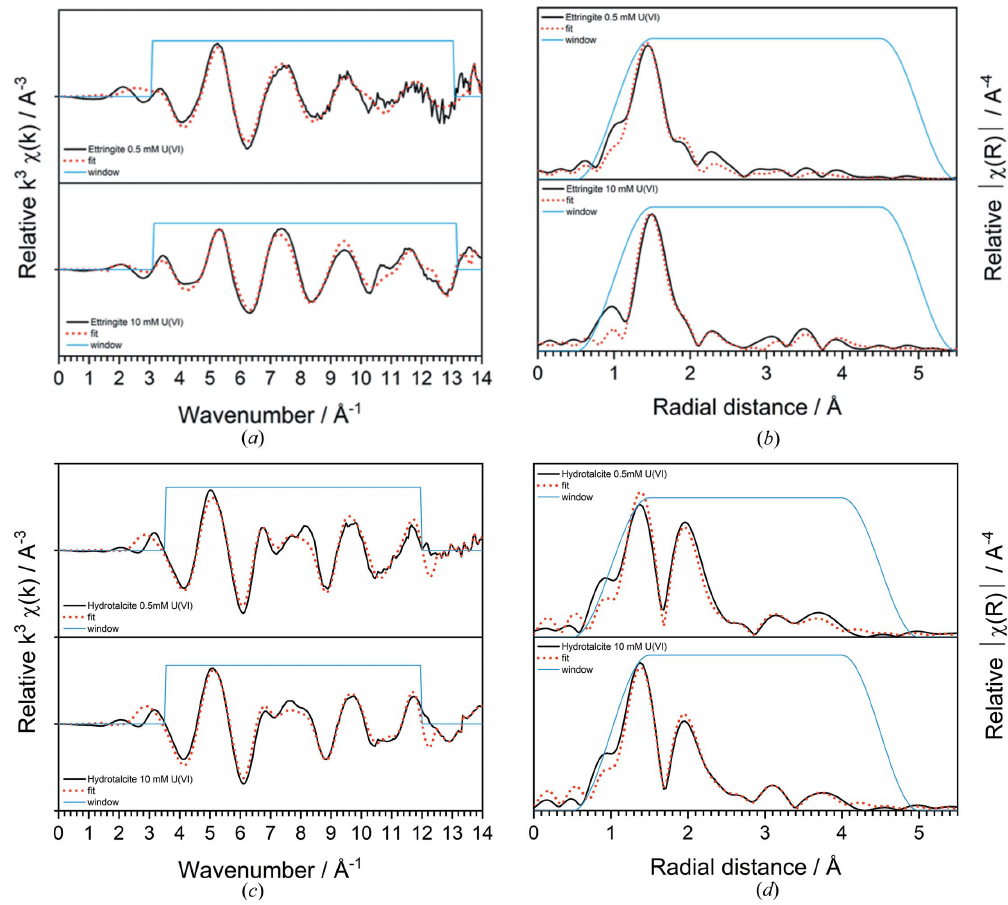
Figure 6 Local coordination analysis of U VI in contact with cement minerals. ( a ) k 3 -weighted spectra and model fit (dashed red lines) for ettringite; ( b ) corresponding Fourier-transformed radial plots; ( c ) k 3 -weighted spectra and model fits (dashed red lines) for hydrotalcite; ( d ) corresponding Fourier- transformed radial plots and